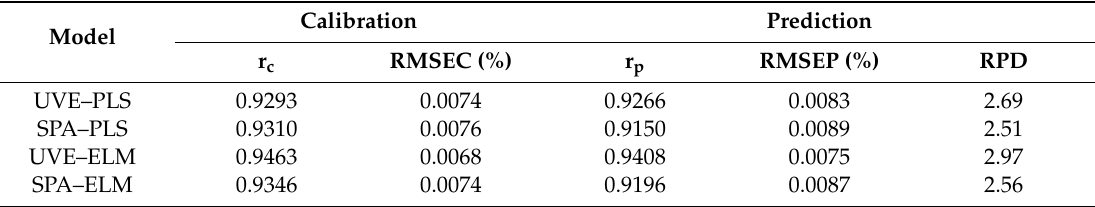
Table 3. The performance of the PLS and ELM models with the characteristic wavelengths selected using UVE and